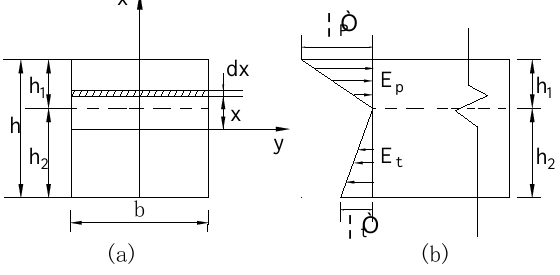
Figure 6: Stress Distribution of Specimen Mid-Span